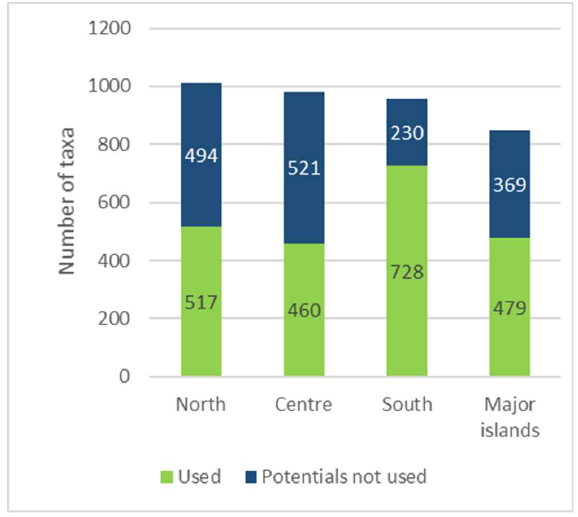
Figure 9. Comparison by geographical area between the number of recorded and potential alimur- gic taxa.